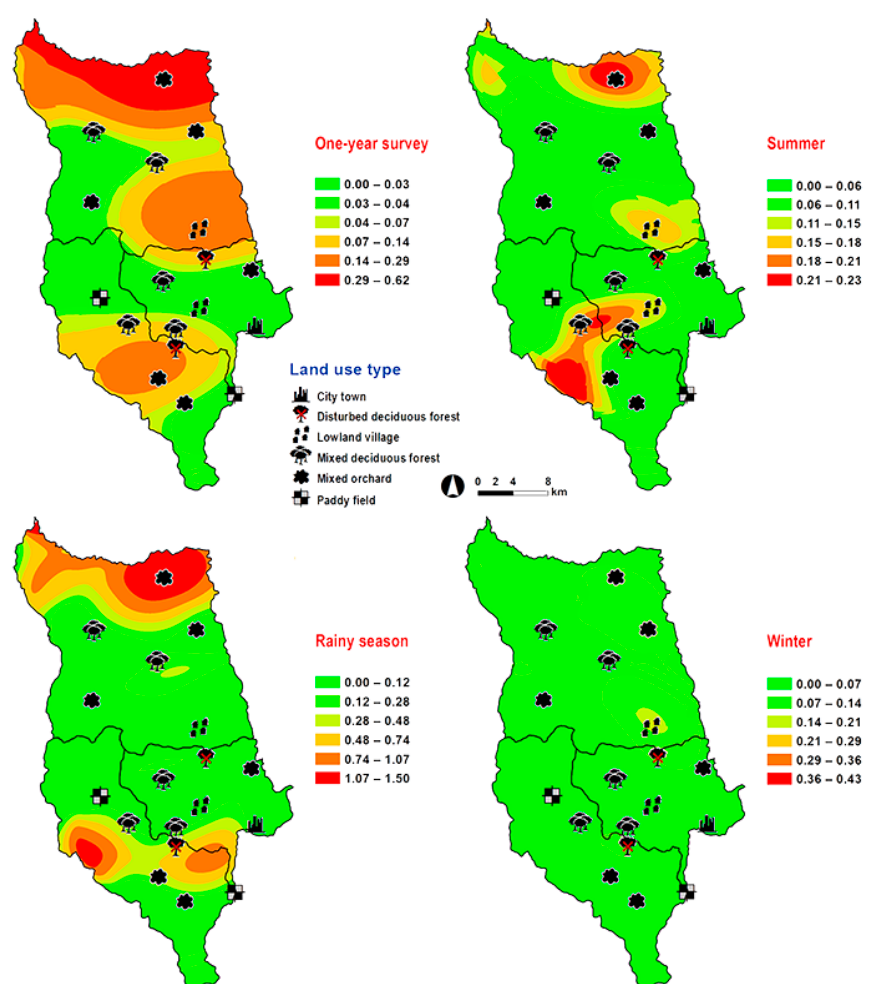
Figure 6. Predictive distribution maps of Hemipyrellia pulchra. The color scheme represented different fly density categories. The red areas represent the highest fly population, while the green represent the lowest population density. The scale corresponds to natural logarithm of (fly density + 1).